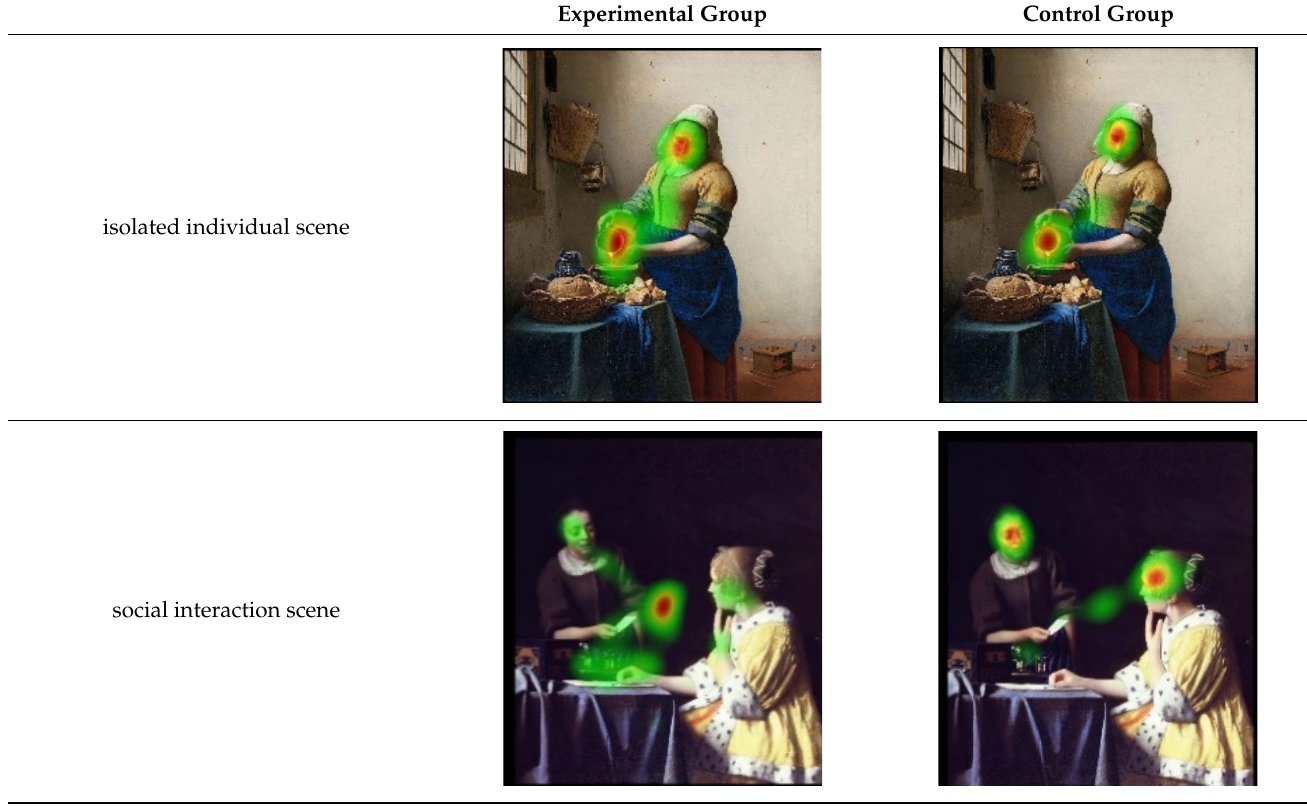
Table 4. Heat maps of experimental group (autistic children) and control group (TD children) looking at different scenes.